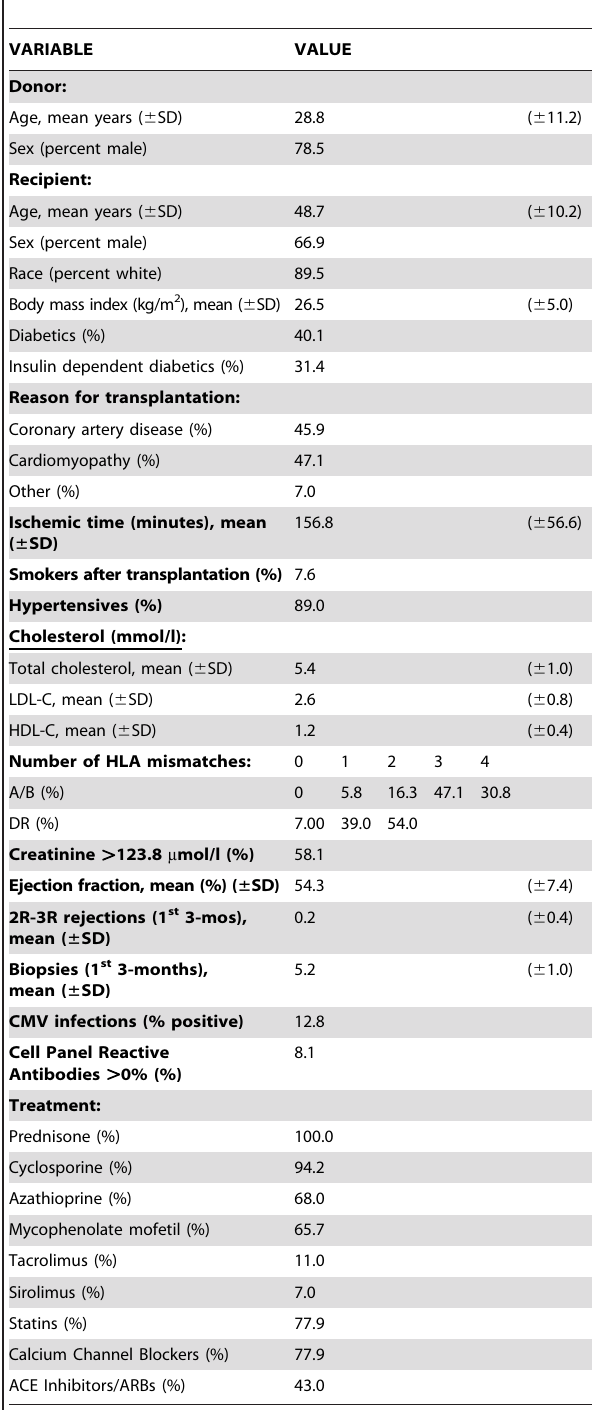
Table 1. Summary of demographic and clinical variables (Patients: n